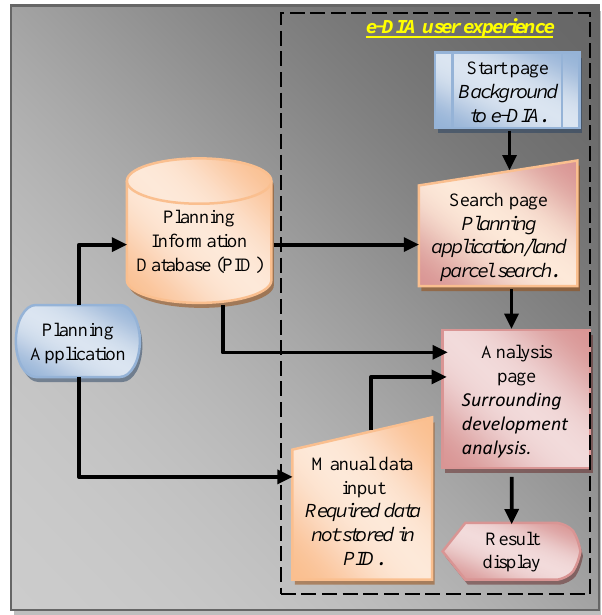
Figure 2: Overview of the e-DIA